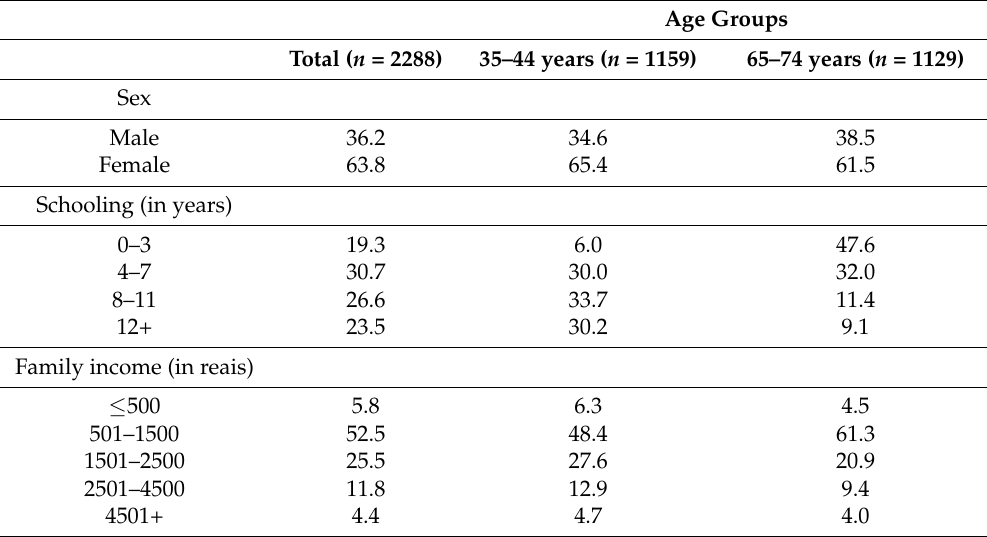
Table 1. Descriptive statistics (%) for the study variables.